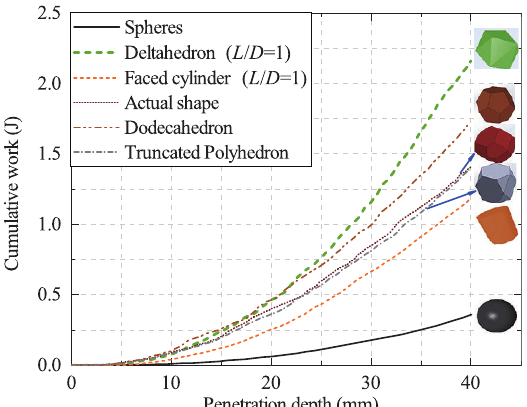
Fig. 4 DEM prediction of expended work to penetrate the im- peller blade of FT4 rheometer into a bed of faceted par- ticles in the standard test method. Simulation data are from Vivacqua et al. (2019): https://doi.org/10.1016/